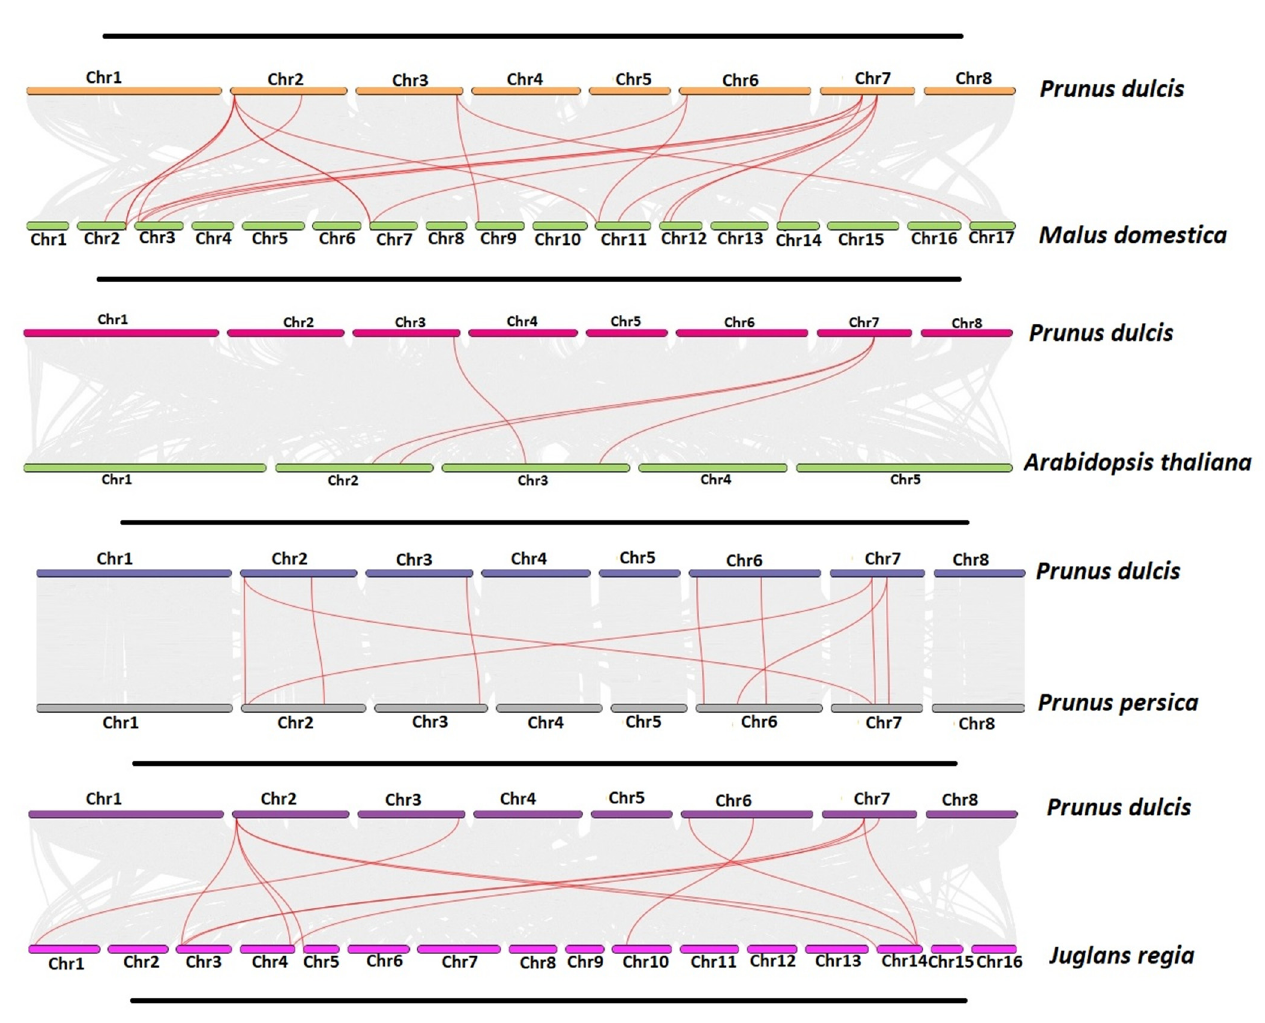
Figure 7. Synteny analysis of PdSAP genes. Synteny analysis of PdSAP with M. domestica , A. thaliana , J . regia, and P . persica . Red blocks indicate the presence of an evolutionary relationship.